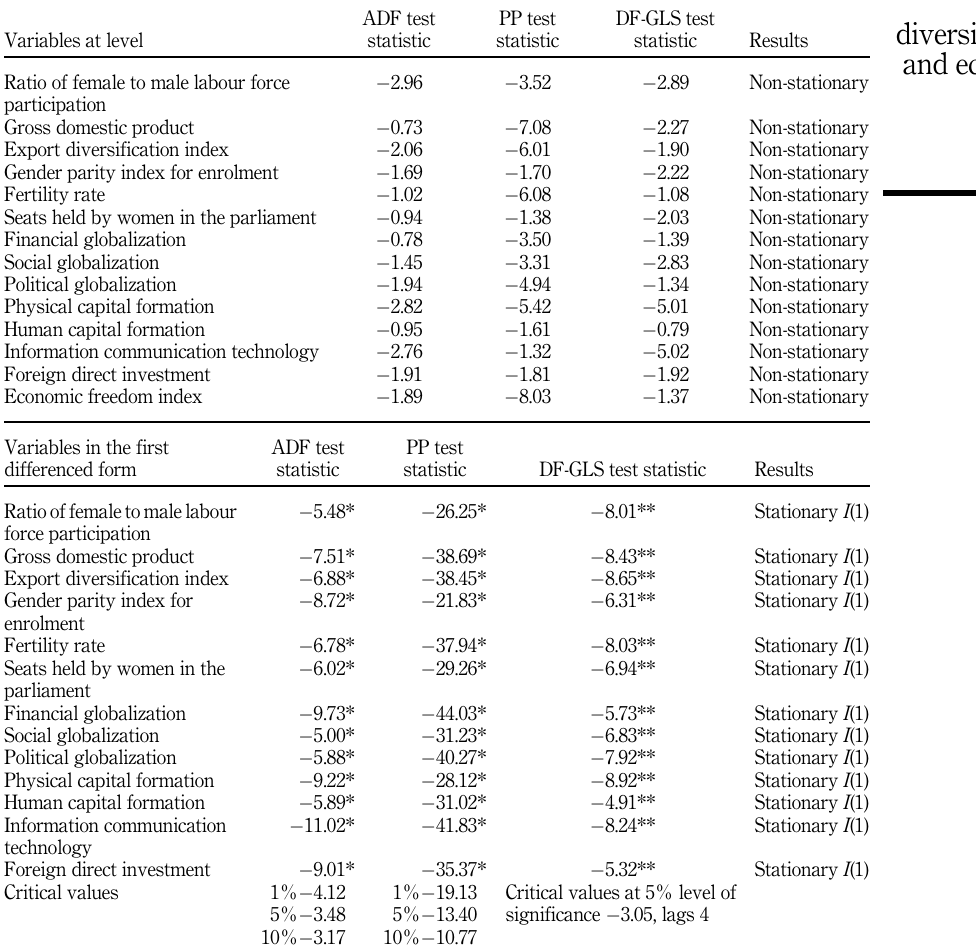
Table A2. Unit root test